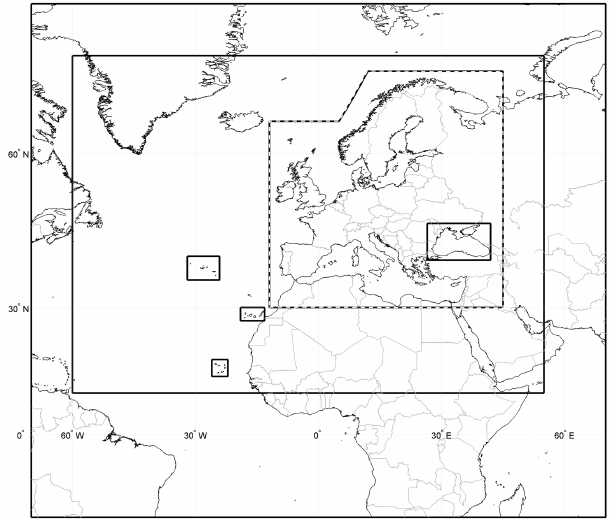
Figure 3. Wave reanalysis domains in Europe.